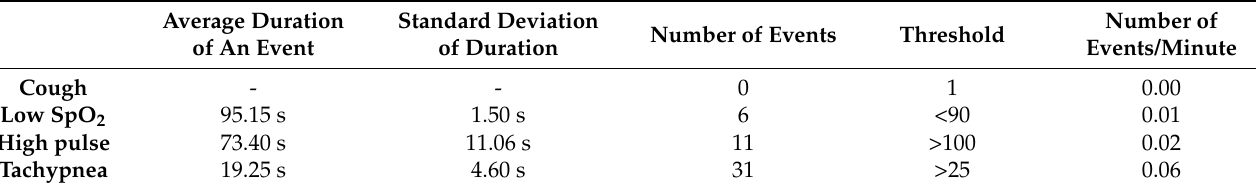
Table 2. Events recorded during the whole study period.